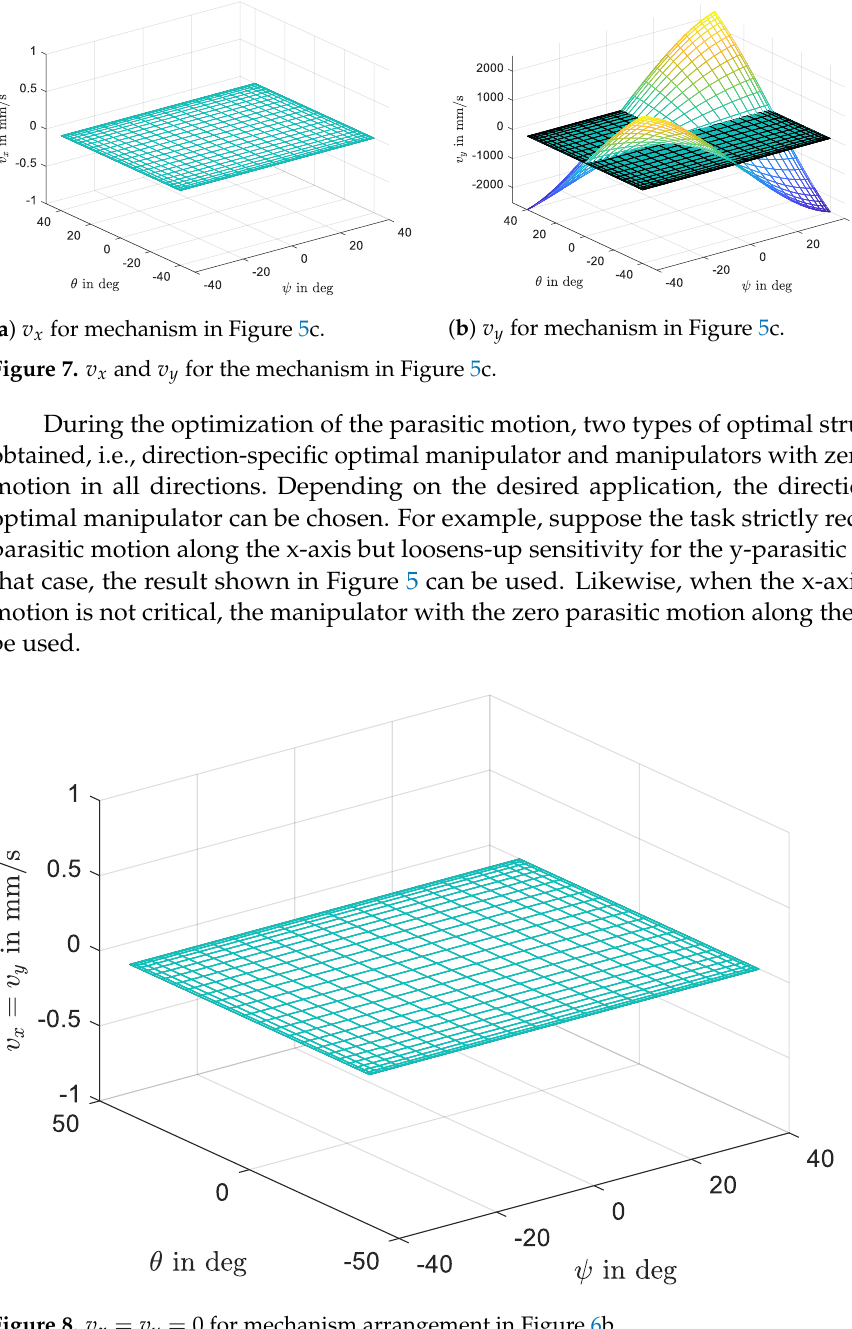
Figure 8. v x = v y = 0 for mechanism arrangement in Figure